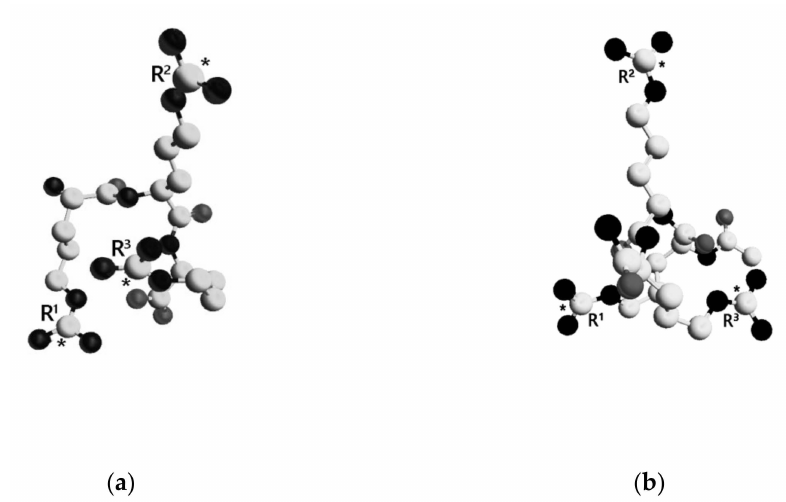
Figure 6. Spatial structure of the lowest energy conformations of TP1 and TP2. The dielectric constant ε = 10. Amino acid residues are numbered. Carbon atoms are presented as white spheres, oxygen atoms—gray, and nitrogen atoms—black. Carbon atoms of the guanidinium groups are marked with asterisks. Hydrogen atoms are not shown for clarity. ( a )—TP1, ( b )—TP2. Table 1. Average distances between the guanidinium groups in TP1 and